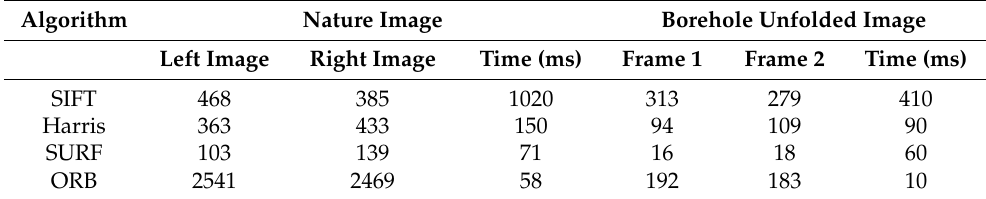
Table 1. Number of feature points and running time.